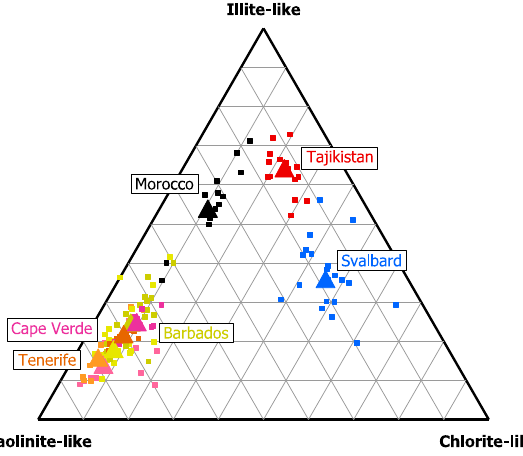
Figure 2. Ternary diagram of the number abundances of major clay mineral compositions in dust dry deposition. Each data point represents one sample. Averages for the different locations are symbolized by the larger triangle. For Tenerife (orange), Cape Verde (rose), and Barbados (olive), data for two campaigns with according campaign averages are shown.